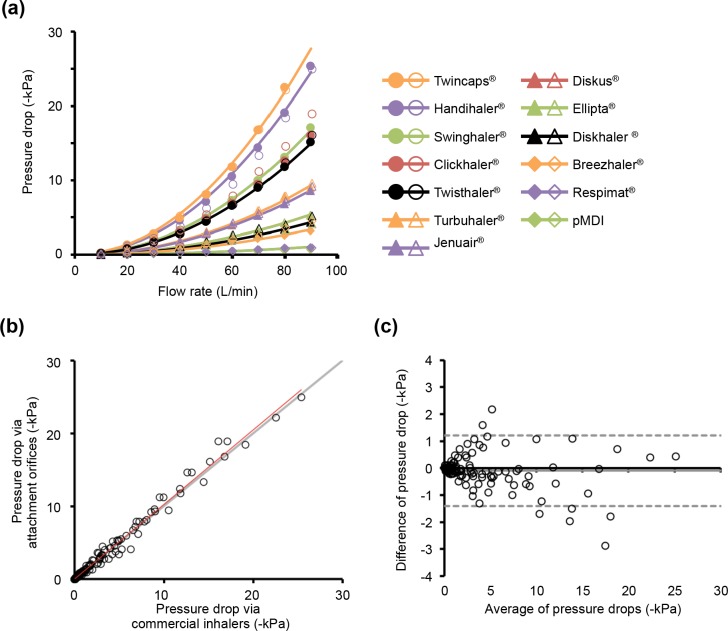
Relationships between inspiratory flow rate and pressure drop of commercial inhalers (filled points) and simple attachment orifices (open points) (a). Relationships of pressure drops between commercial inhalers and orifices (b). Gray and red lines represent y = x and approximated line (y = 1.024 x + 0.003, R2 = 0.9851), respectively. Bland-Altman plot for relationship of pressure drops between commercial inhalers and orifices (c). Gray solid and dotted lines represent bias and 95% limit of agreement interval of difference of pressure drop between commercial inhalers and orifices (-0.10, -1.38 to 1.18), respectively.